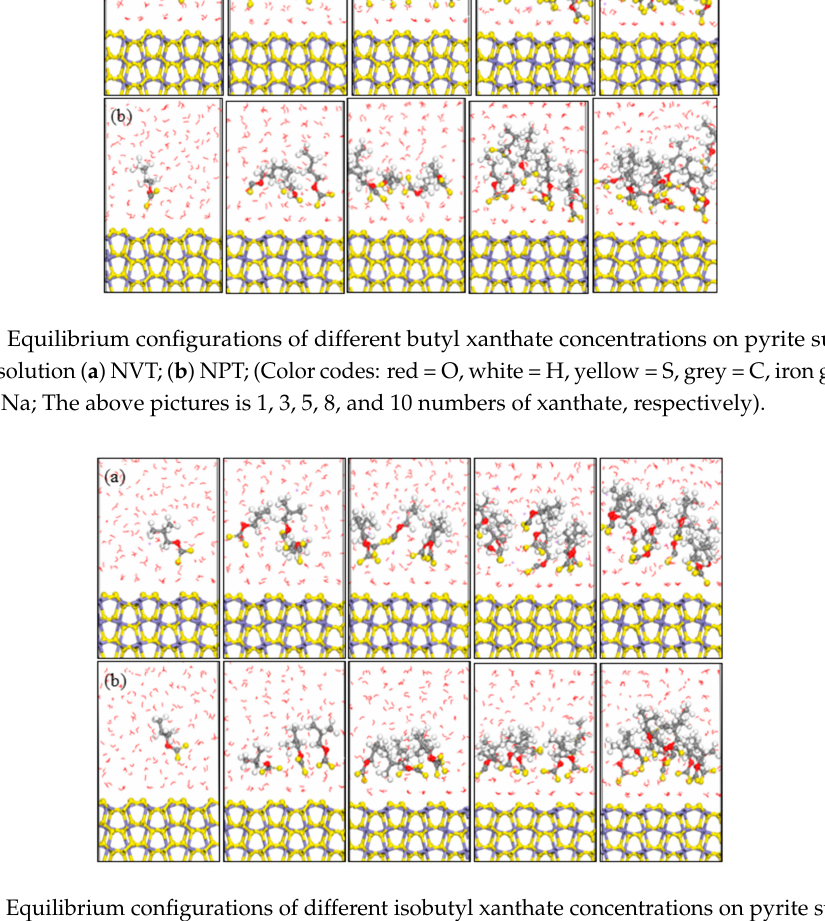
Figure 5. Equilibrium configurations of different isobutyl xanthate concentrations on pyrite surface in aqueous solution ( a ) NVT; ( b ) NPT; (Color codes: red = O, white = H, yellow = S, grey = C, iron grey = Fe, purple = Na; The above pictures is 1, 3, 5, 8 ,and 10 numbers of xanthate,